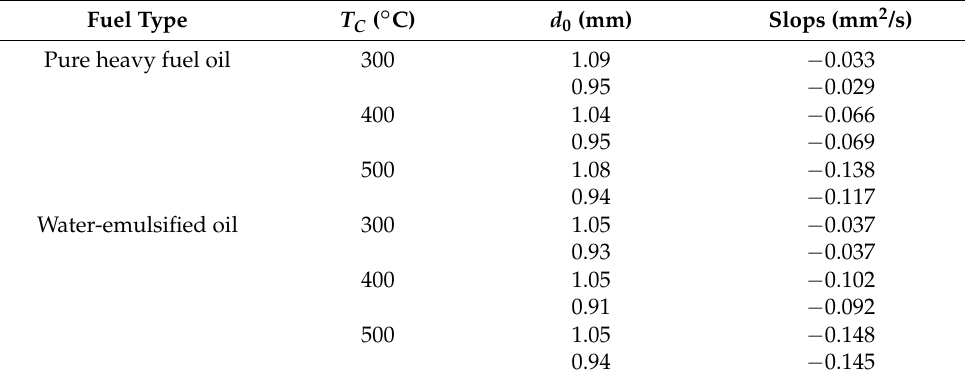
Table 2. Variations in the droplet evaporation slope with ambient temperature, droplet size, and fuel